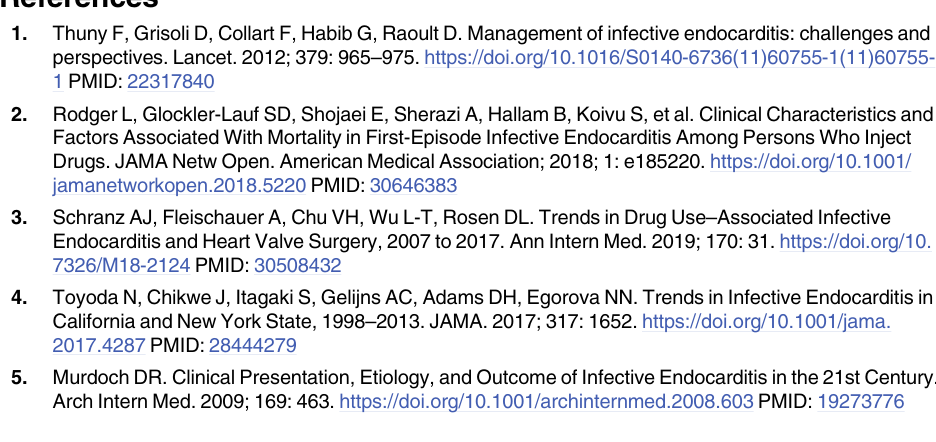
S1 Table. The opioids used in this study. S2 Table. Clinical bacterial isolates from active PWID that were used in this study. (DOCX) S3 Table. Primary